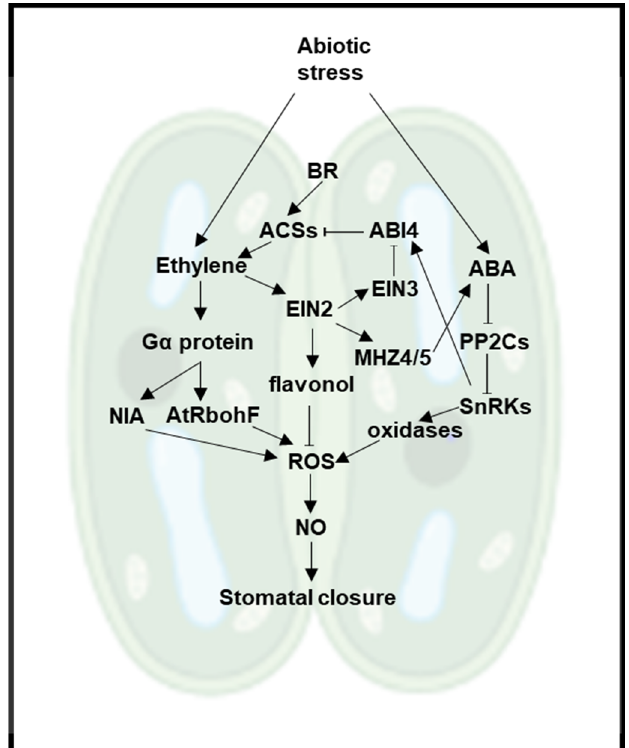
Figure 3. A model of stomatal closure regulation by crosstalk between ABA, BR, and ethylene in Arabidopsis. Endogenous ABA and ethylene accumulate in response to abiotic stress. The biosynthesis of ethylene is upregulated by BR but repressed by ABA due to the transcriptional regulation of ACS genes. The ABA biosynthesis is upregulated by ethylene through MHZ4/5 . ABA induces ABI4 transcript levels and the ABI4 protein, in turn, represses the transcription of the ACS genes. Ethylene also regulates stomatal closure via two ROS-dependent pathways. One pathway is mediated by the ethylene-triggered activation of the G α protein, which in turn promotes H 2 O 2 production by activating the NADPH oxidase gene AtRbohF and by inducing NO accumulation via the transcriptional upregulation of the nitrate reductase gene NIA1 . The increased ROS (H 2 O 2 and NO) results in stomatal closure. The second pathway, vice versa, links ethylene with reduced ROS levels via EIN2-dependent synthesis of flavonols, secondary metabolites that serve as ROS scavengers. Conversely, high levels of ABA signaling lead to elevated ROS production and stomatal closure. Positive interactions such as activation, production, and stabilization are represented with lines that end in an arrowhead → . Negative interactions such as inactivation and repression are represented by lines that end in a hammerhead ⊣ . The background image of stomata was created with BioRender.